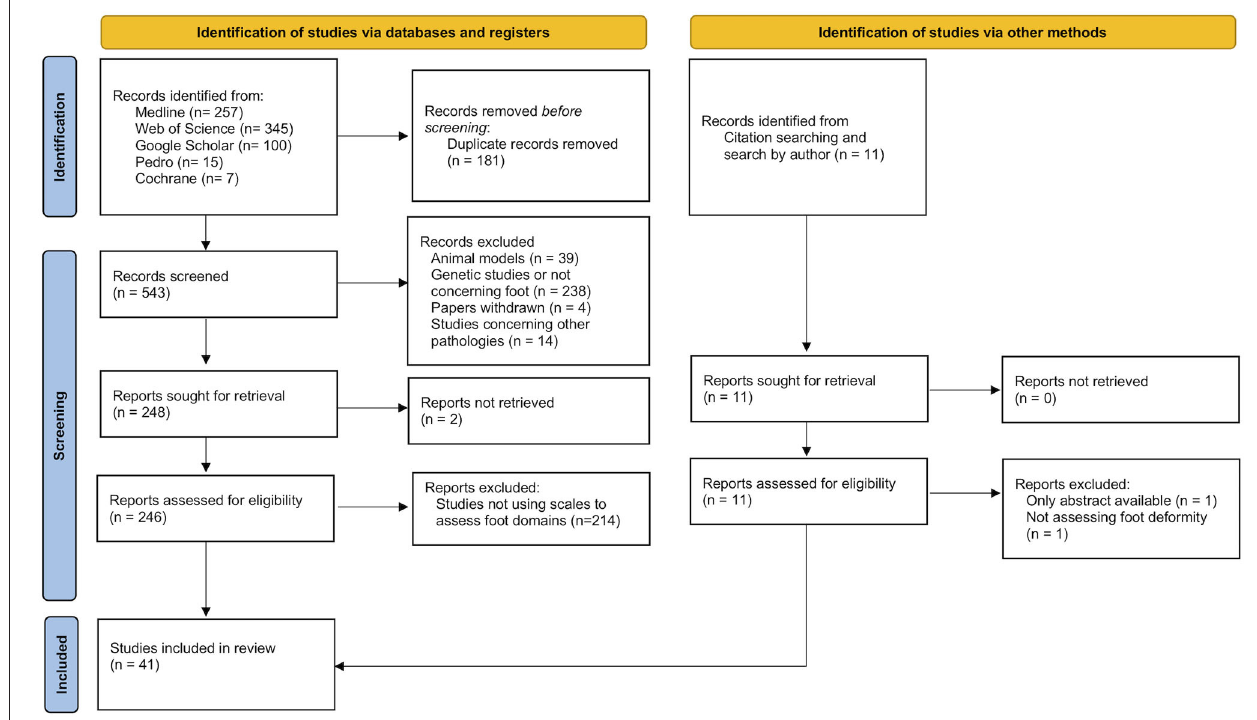
FIGURE 1 | Flow diagram of the selection process of papers using clinical scales to assess foot deformity in CMT